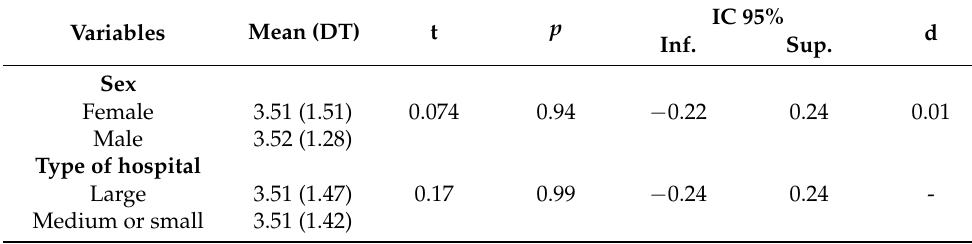
Table 6. T -test for work-related lateral